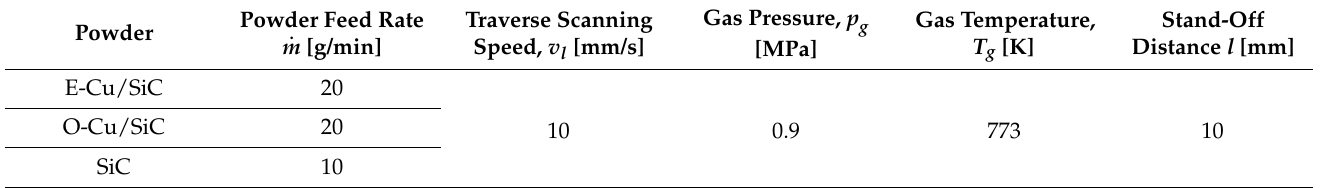
Table 1. Low pressure cold-spraying process parameters.